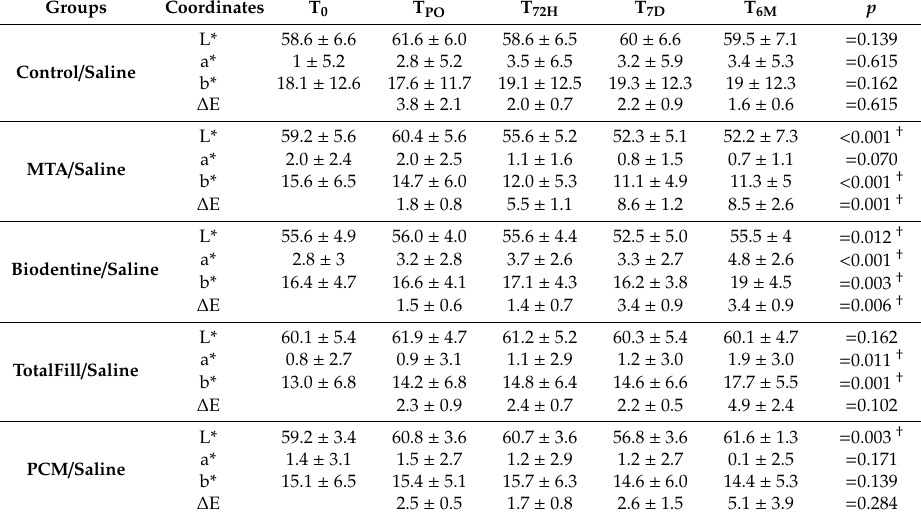
Table 2. Mean and standard deviation values of each of the L* a* b* coordinates of each experimental group for all periods of evaluation. ∆ E values express color variation from baseline (T 0 ) to each evaluation timepoint (T PO , T 72H , T 7D , and T 6M